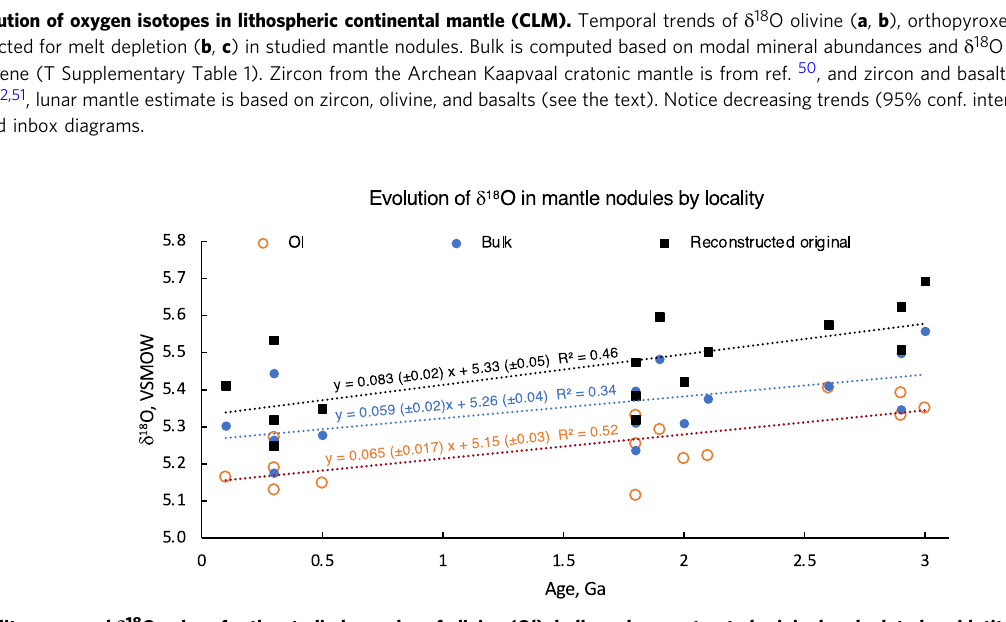
Fig. 2 Locality-averaged δ 18 O values for the studied samples of olivine (Ol), bulk, and reconstructed original undepleted peridotite (see Fig. 3). Line fi t statistics indicate decreasing